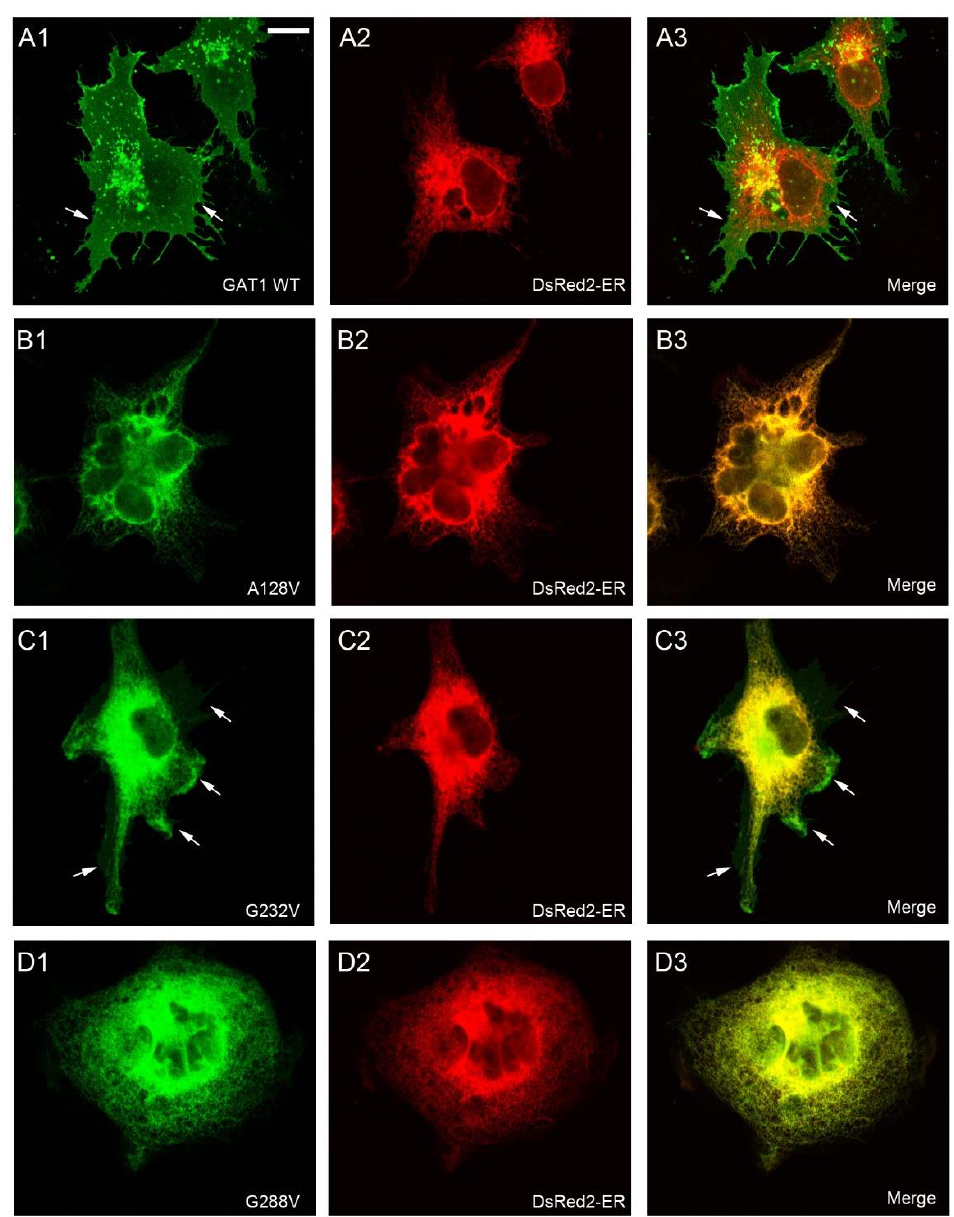
Figure 4. Subcellular distribution of GAT-1 variants in transfected cells. COS7 cells were transfected with expression vectors for HA-GAT-1 WT ( A1 – A3 ) or the indicated HA-tagged mutants: A128V ( B1 – B3 ); G232V ( C1 – C3 ); G288V ( D1 – D3 ). Transfection mixture also contained the expression